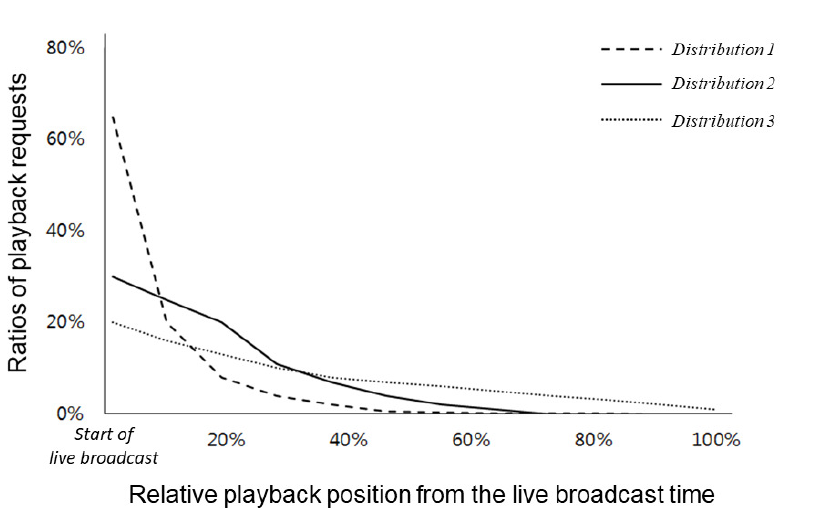
Figure 5. Three types of playback request distributions according to the concentration degree around the live broadcast